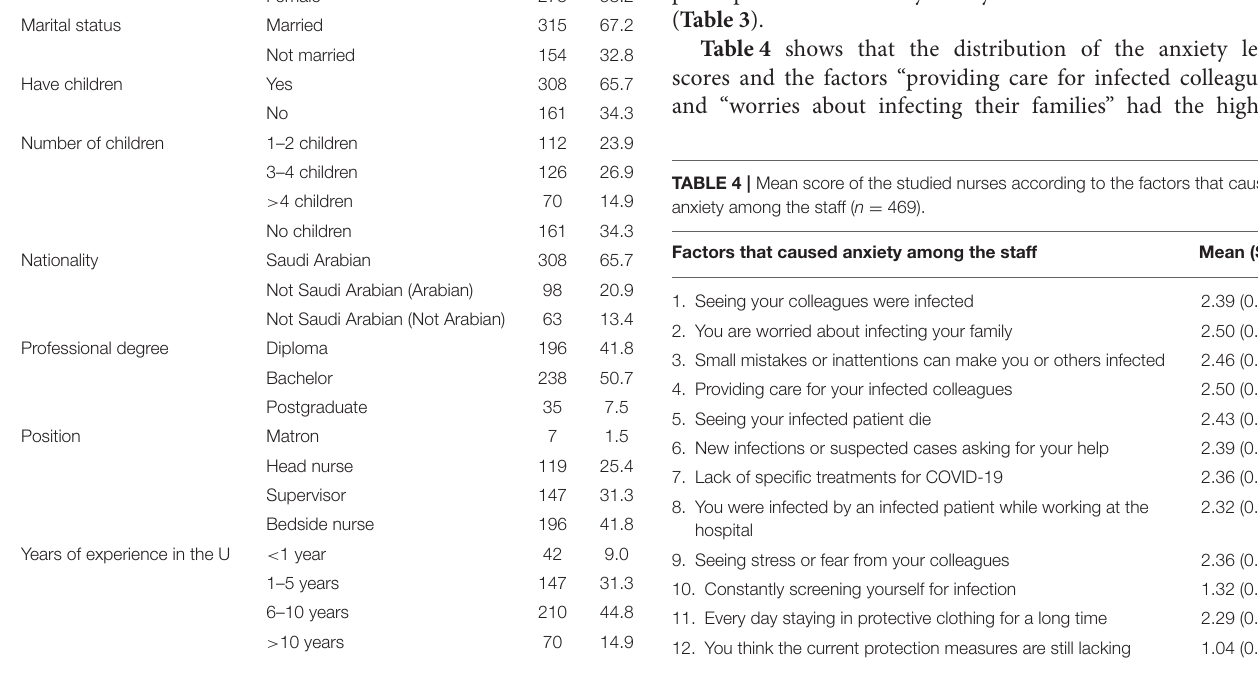
TABLE 2 | Level score of Generalized Anxiety Disorder toward coronavirus disease 2019 (COVID-19) according to critical care nurses’ gender. Level of generalized anxiety disorder 7-item scale score